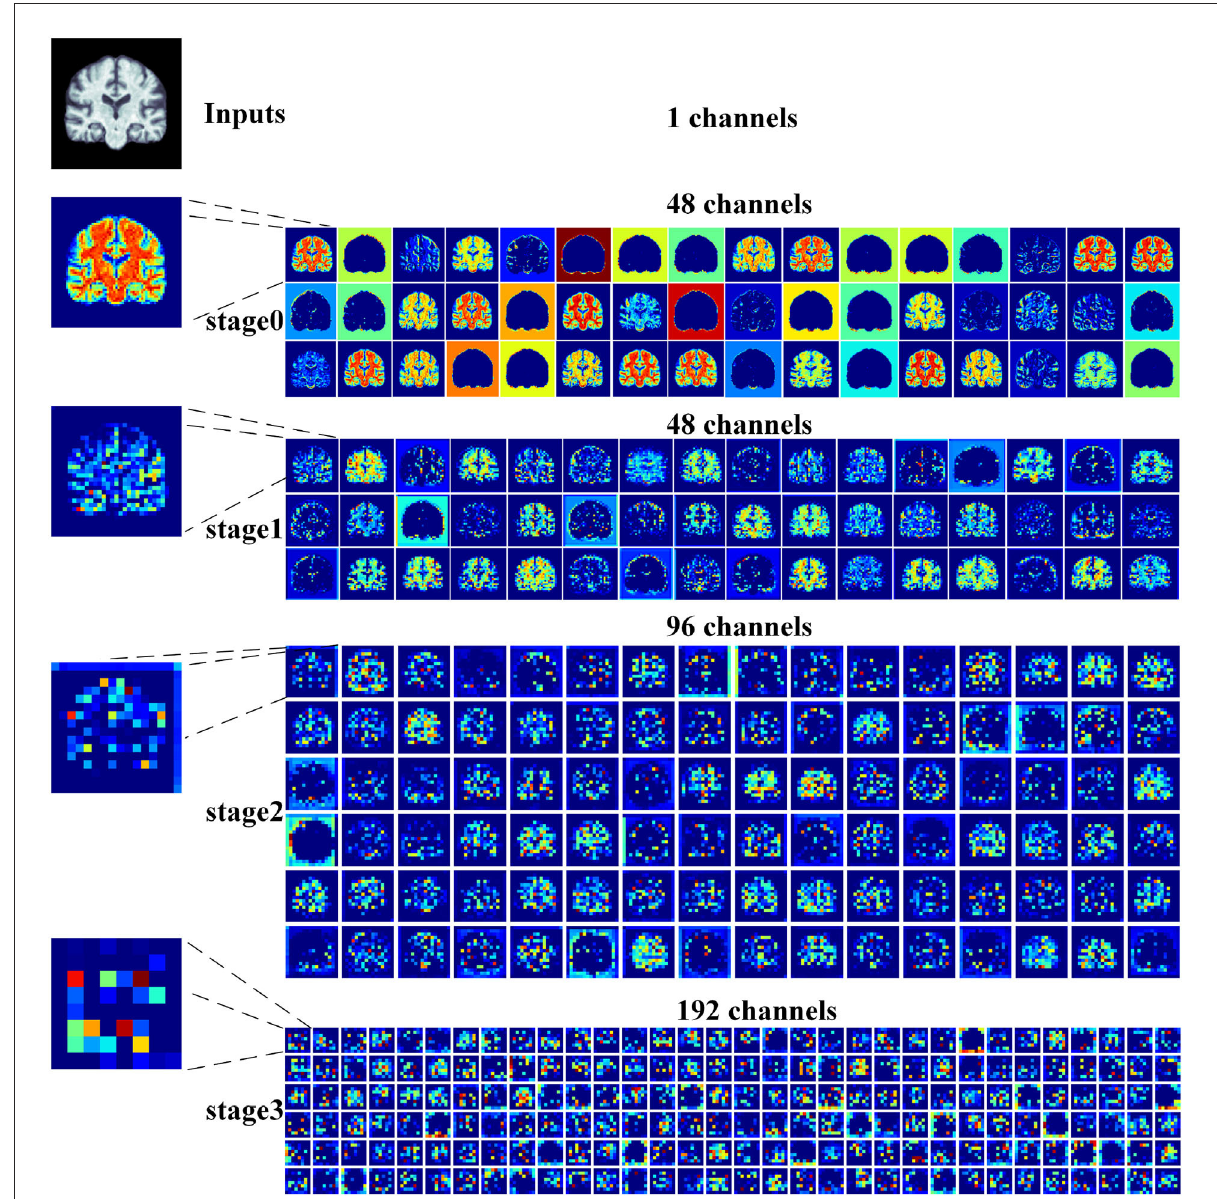
FIGURE5 Grad-CAM visualizations of the feature maps produced at different stages by the RepResANet encoder parts. All channel features are derived from one slice of the 3D MRI.